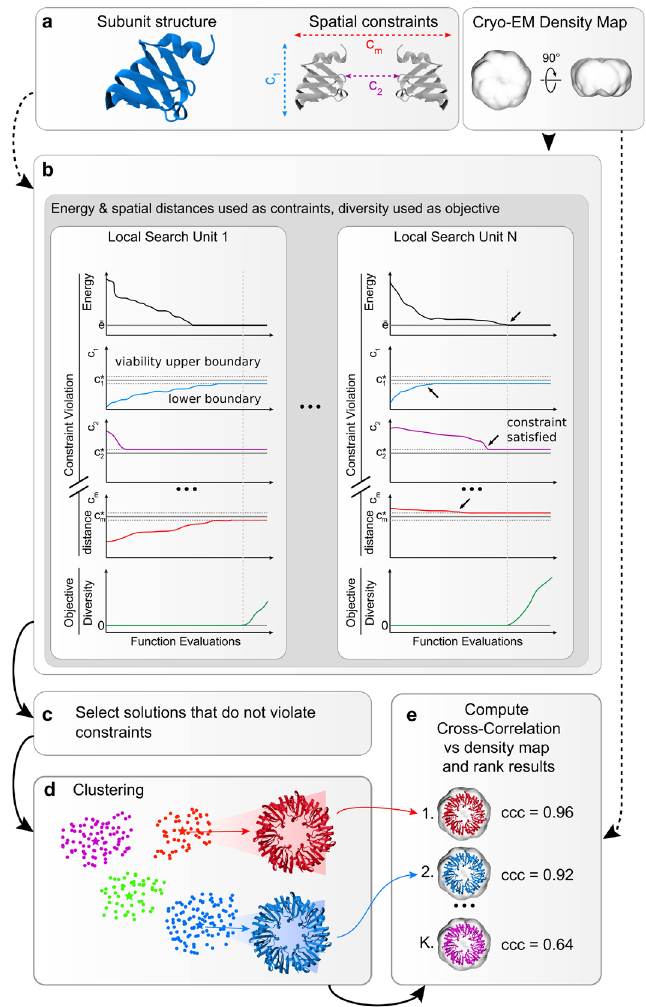
Figure 1. Assembly prediction using mViE algorithm. ( a ) The protocol requires as input structures at atomic resolution of the subunits forming the assembly, a set of spatial constrains obtained by experiments that characterize the connectivity of the complex, and/or volumetric density maps providing information about the general complex architecture. ( b ) mViE uses a population of multiple search units that try to independently minimize each constraint violation defined either as energy for the coarse energy potential or as C {1, 2, … m} for the residue spatial distances. Once a search unit discovers assemblies that satisfy all the constraints, i.e. that are within the viability upper and lower boundaries defined on the constraints (black arrows on left panel), it tries to discover assemblies that maximize the diversity with respect to the assemblies predicted by the other search units. This is performed by favoring solutions that are at a larger Euclidean distance in the search space with respect to other local search units. ( c ) Candidate assemblies that do not violate the constraints are ( d) hierarchically clustered and the clusters centroids are extracted. ( e ) The centroids are ranked on their cross- correlation coefficient ( ccc ) computed against the provided density map and the top-ranked predictions are returned to the user. Notice that density maps can be used a priori as objective or a posteriori for